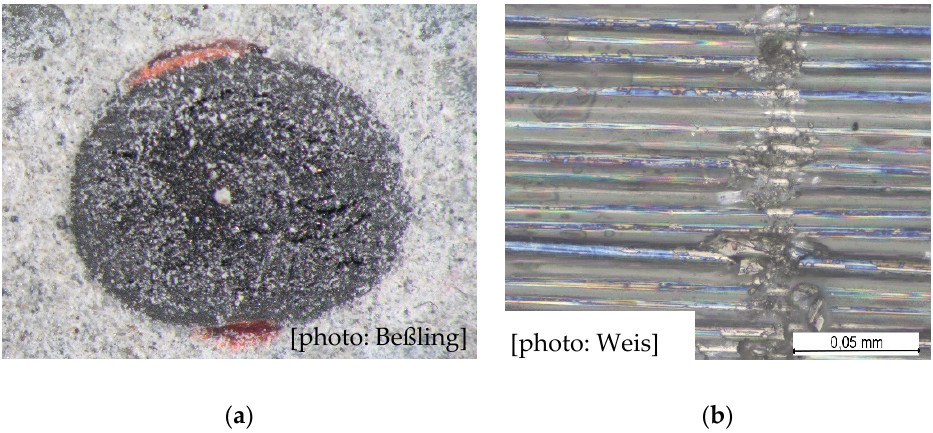
Figure 2. Details of yarns made of carbon: ( a ) incompletely impregnated yarn strand (cross-section), ( b ) fiber cracks due to the manufacturing process.